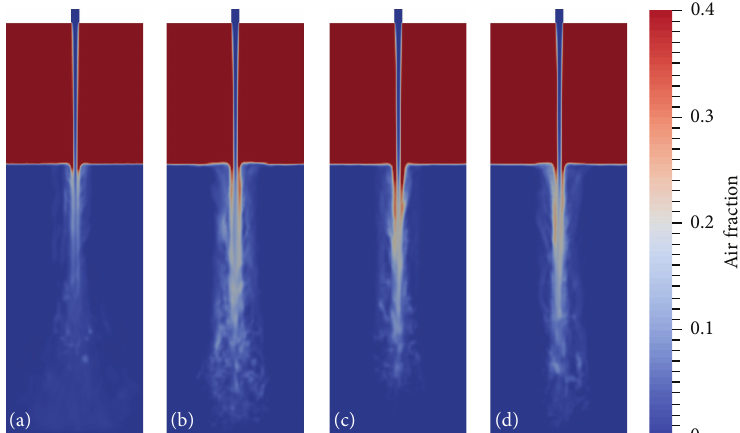
Figure 9: Time-average gas fraction profile on cross-sectional plane for diameter, switching configurations (a) rPBE, normGrad, (b) rPBE, dropSize, (c) We = 2.5, dropSize, and (d) We = 1.2, dropSize. The colorbar upper range has been truncated at 0.4 to enhance the visibility of the plume in the liquid